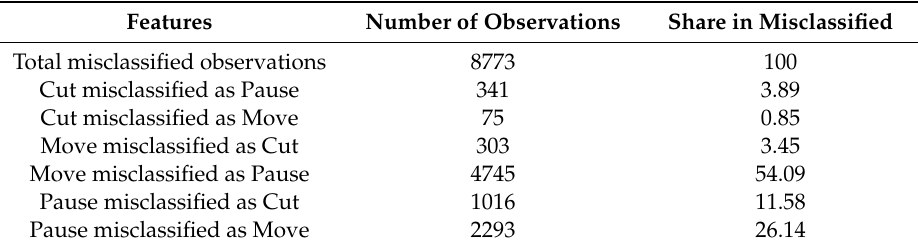
Table 5. Number and share of misclassifications in the testing